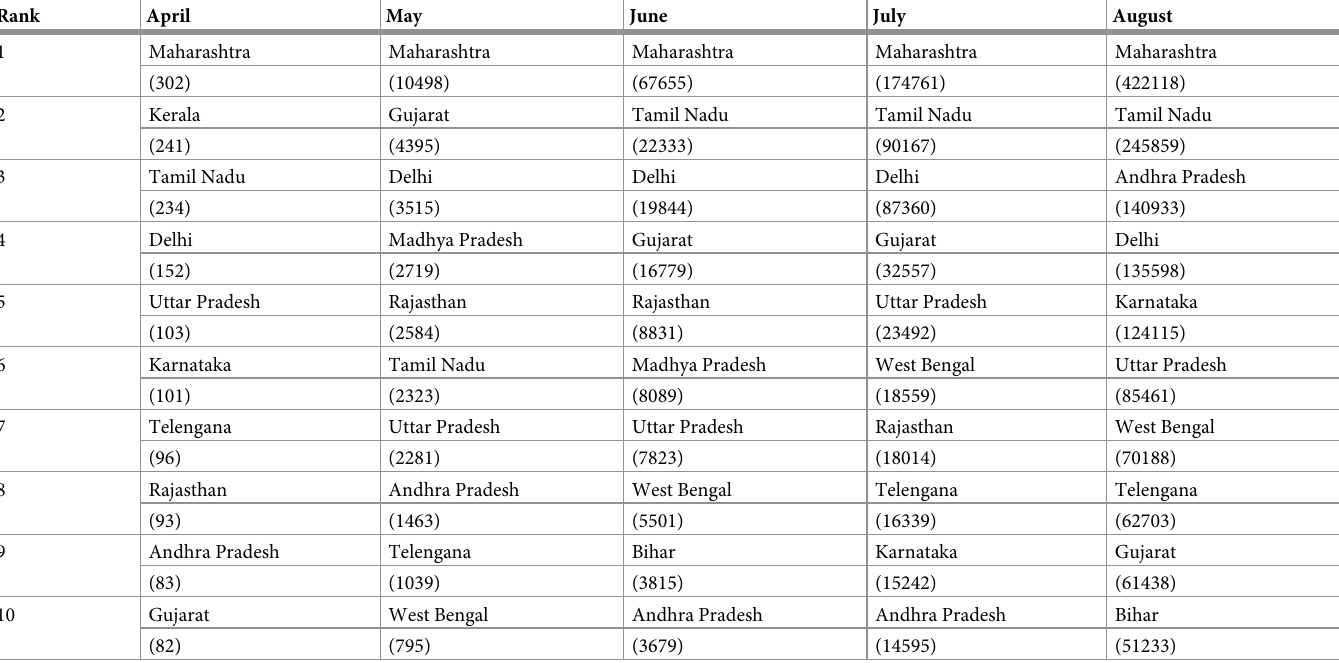
Table 1. Rank of states by number of novel total cases taken at the 1st of every month for April to August 2020 [15]. The number of novel cases are shown in